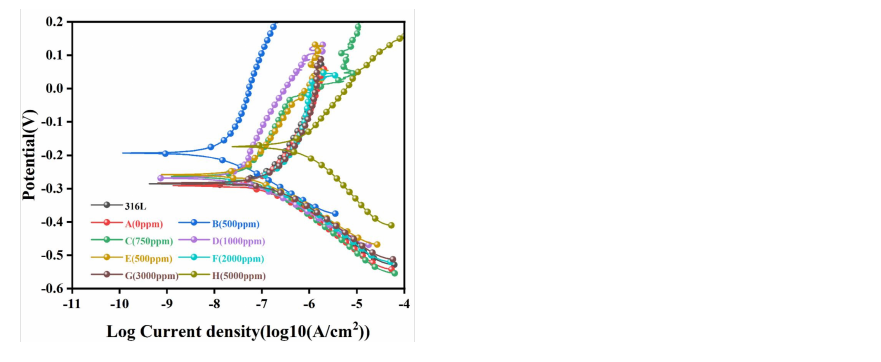
Figure 9. Polarization curves of sintered 316 L stainless steel and novel nitrogen-free austenitic stainless steel samples with the addition of graphite.